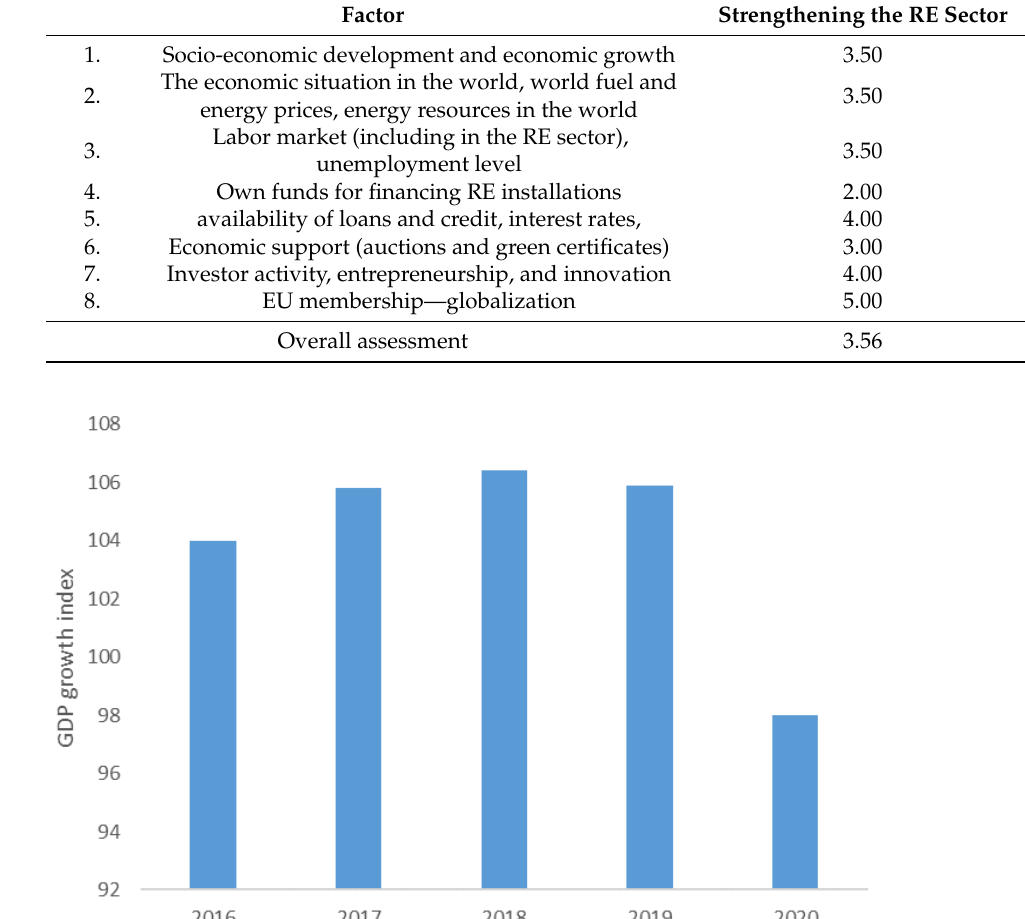
Table 2. The economic factors of RE in the Pomerania Voivodeship (author’s own work).